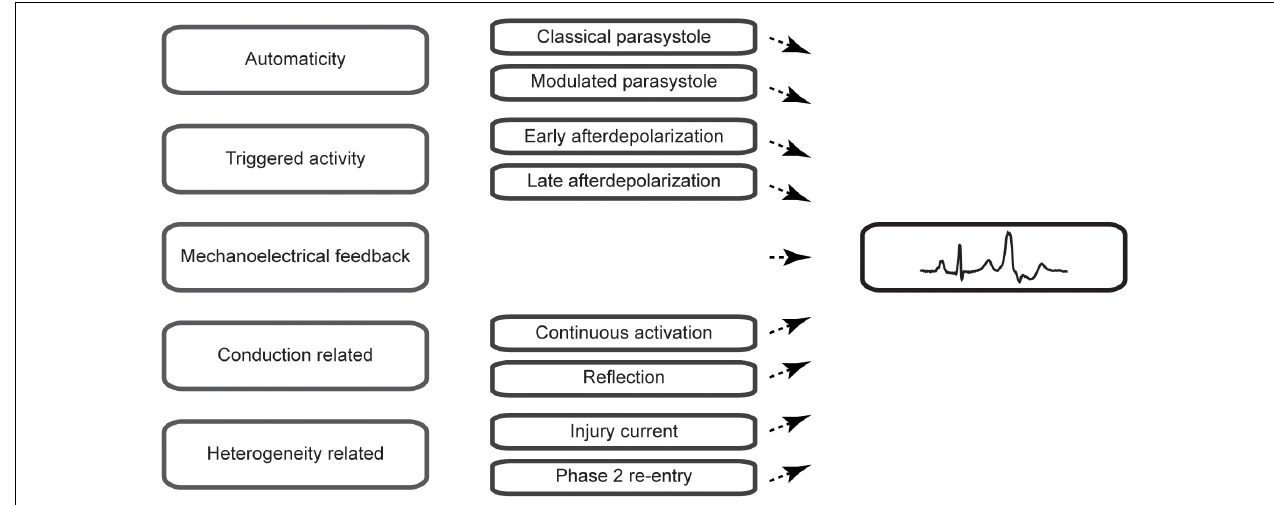
FIGURE 1 | Schematic overview of the mechanisms of premature ventricular complexes covered in this